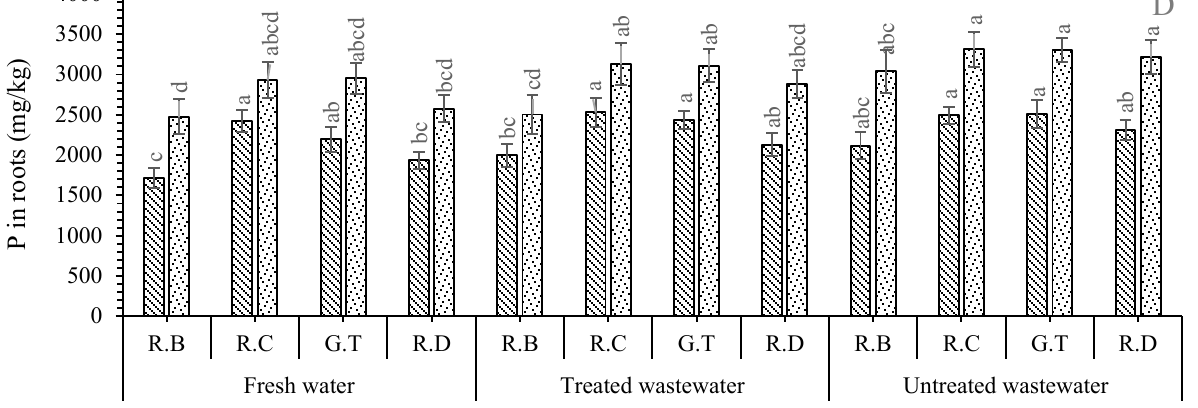
Figure 2. Mean concentration of P in plant parts, i.e., flowers ( A ), leaves ( B ), stems ( C ), and roots ( D ), of Rosa species under different irrigations. Each vertical bar represents the average of three replicates. Different letters indicate significant differences among treatments at p ≤ 0.05 according to least significant difference test. R.B: Rosa bourboniana , R.C: Rosa centifolia , G.T: Gruss-an-teplitz, R.D: Rosa damascena.